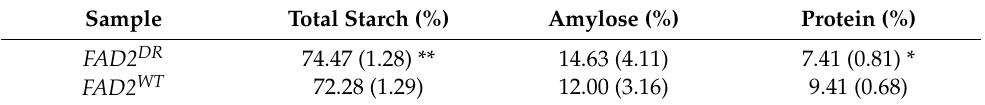
Mean values are the average of three independent lines of each genotype. Standard deviations are shown in the brackets. * and ** indicate the significance of difference at p < 0.05 and p < 0.01,